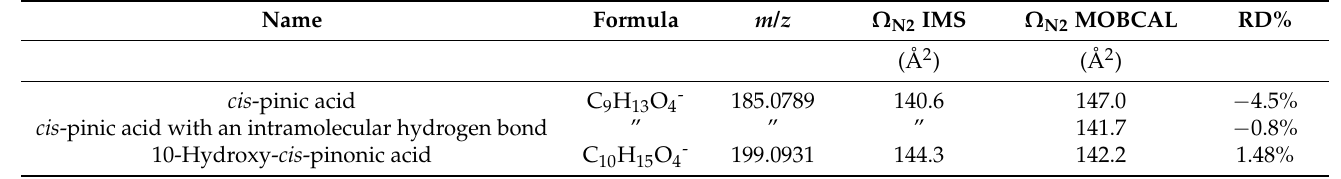
Table 2. Theoretical and measured Ω N2 values of product ions of m / z 367 (C 19 H 27 O 7- ) ion.